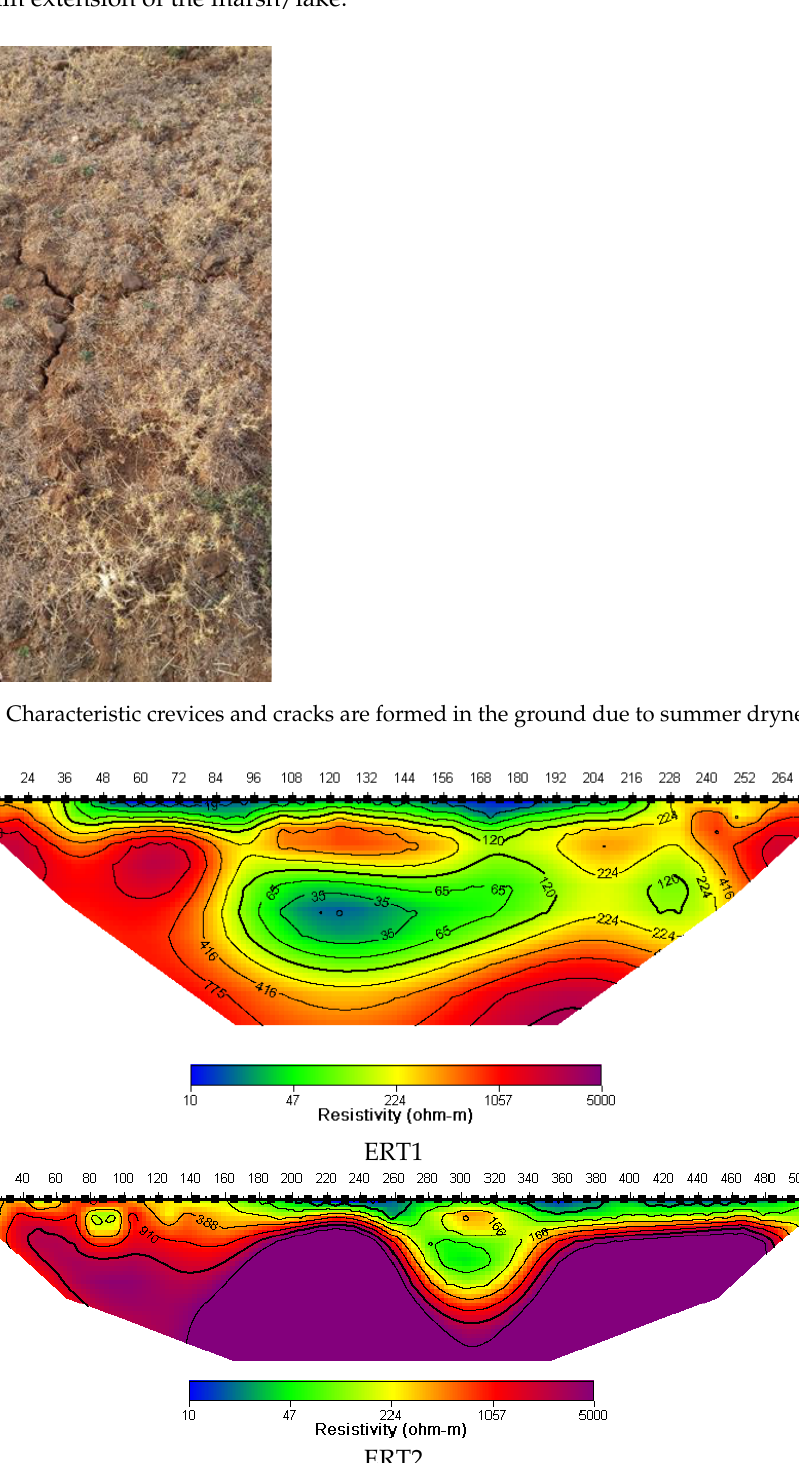
Figure 6. Electrical resistivity tomographies along the profiles ERT1 and ERT2.